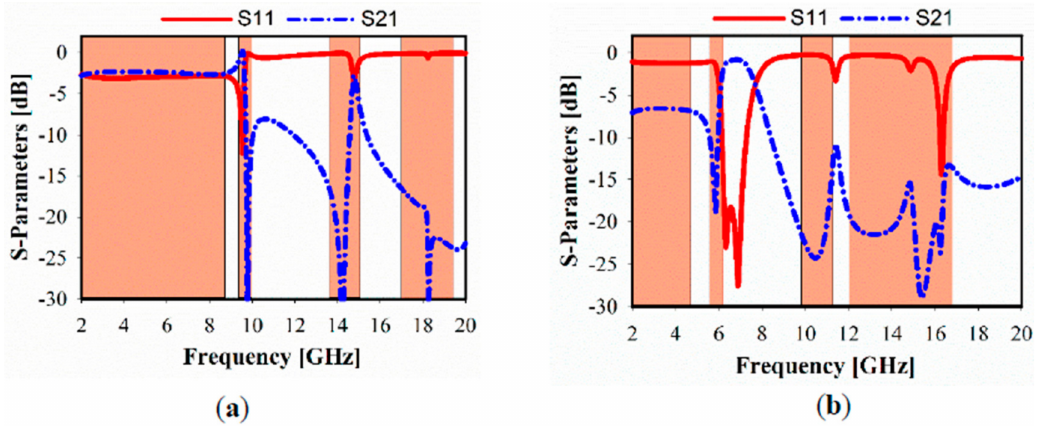
Figure 3. Simulated metamaterial reflection and transmission coe ffi cients: ( a ) x-axis, ( b )